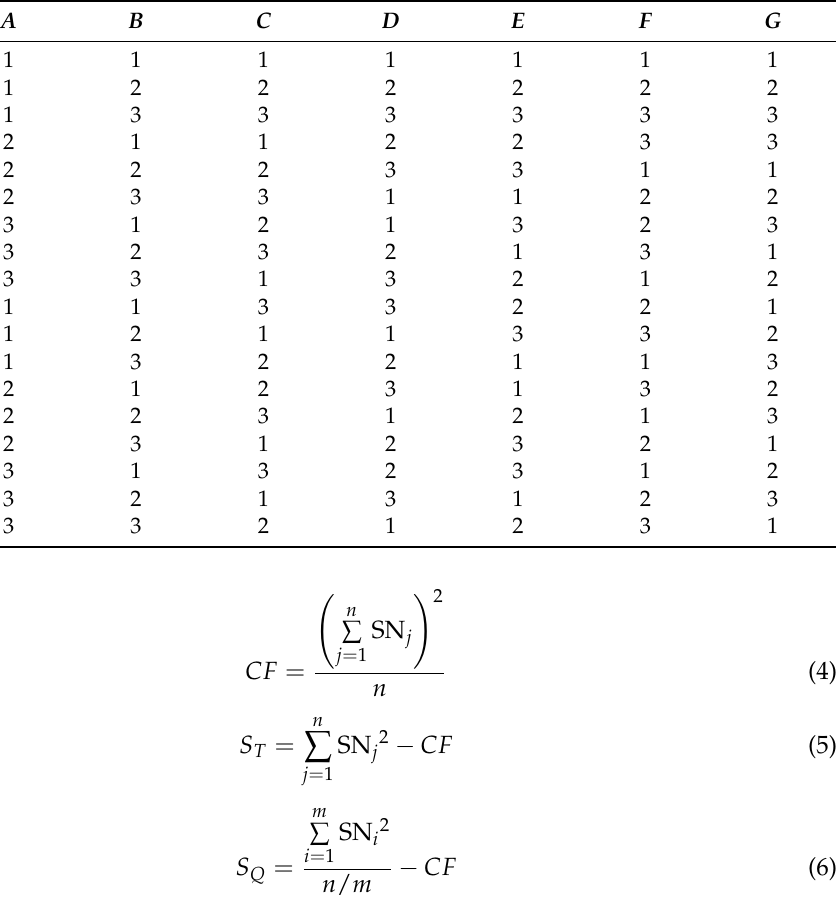
Table 2. L 18 ( 2 1 × 3 7 ) orthogonal test